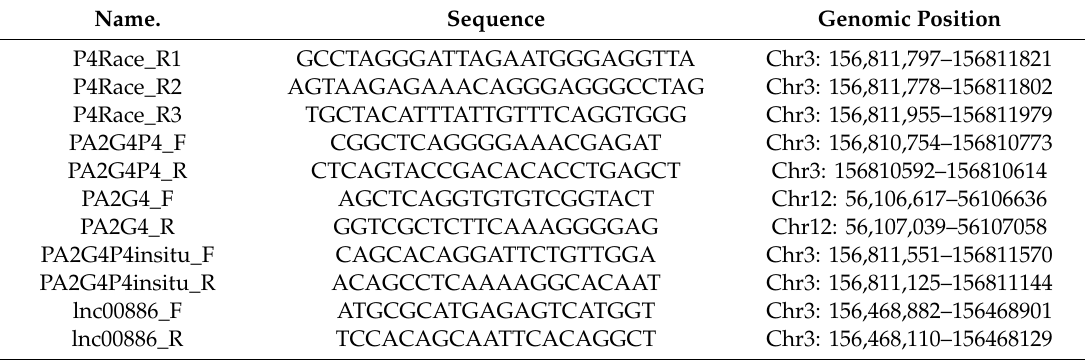
Table 2. List of RACE and RT-qPCR